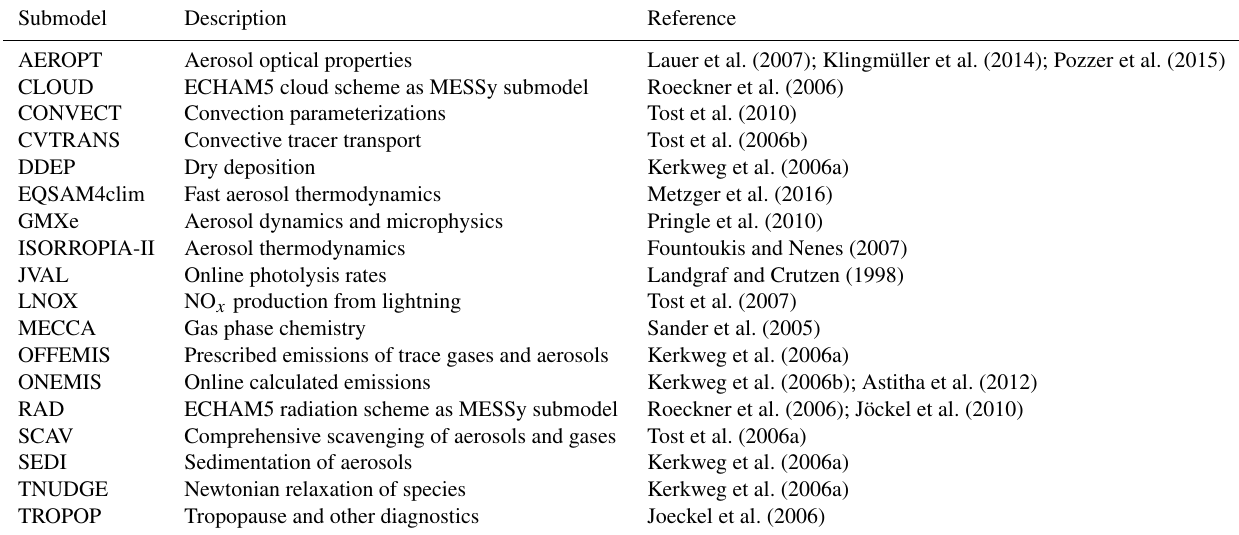
Table 1. The EMAC submodels used in the current study and the corresponding references. Submodel Description